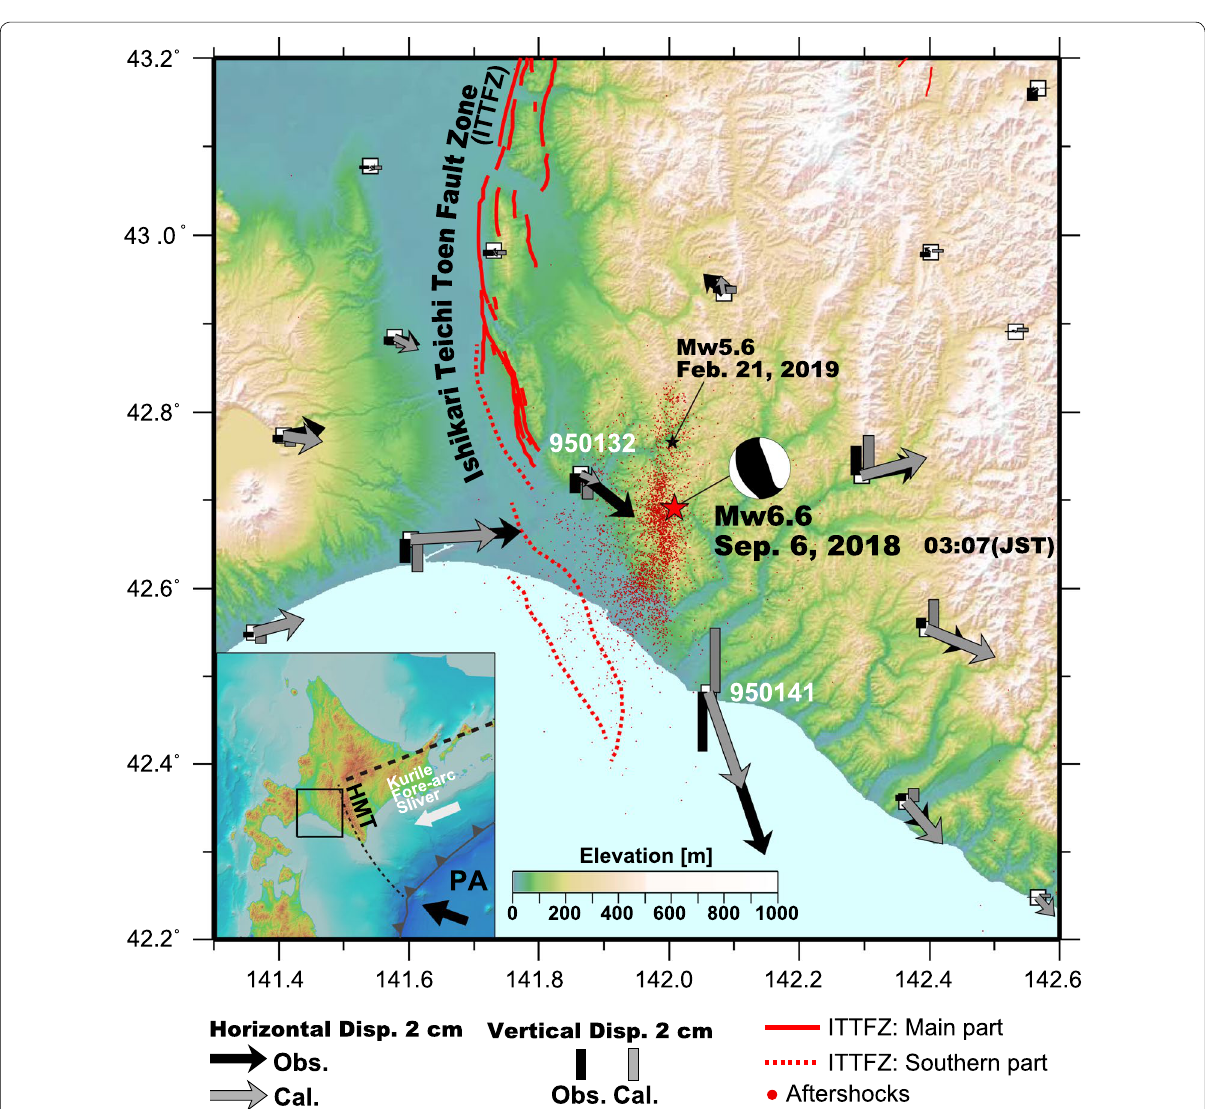
Fig. 1 Study area and GNSS-derived displacements. Star indicates the epicenter of the Eastern Iburi earthquake (2018a). White squares are GNSS sites, and arrows and bars represent coseismic horizontal and vertical displacements, respectively. Black and gray colors represent the observed and model-predicted displacements, respectively. Red lines indicate fault traces of the Ishikari-Teichi-Toen fault zone, from the Headquarters for Earthquake Research Promotion (2010). The beach ball diagram is from JMA (2018b). The inset at the bottom-left shows the tectonic setting of the study area. PA Pacific Plate, HMT Hidaka